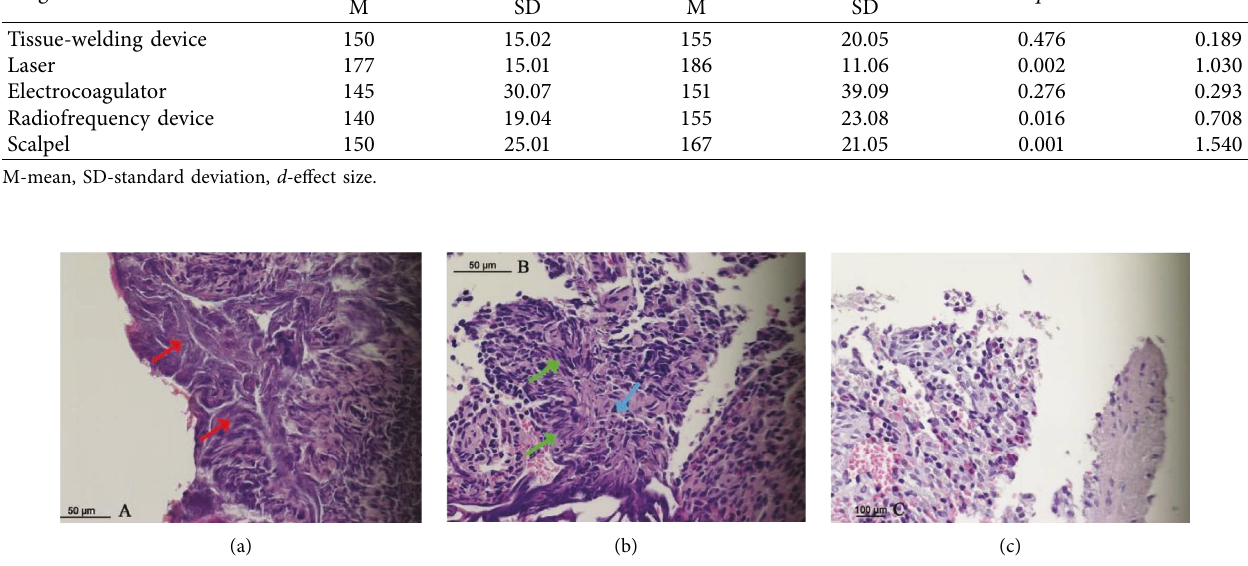
Figure 1: Different cellular changes following the use of various cutting methods. (a).Cut made with a tissue-welding device, obscured and disorganized cells (red arrow). (b).Cut made with a laser, starched nucleus (green arrow) and karyolysis (blue arrow). (c).Cut made with a scalpel with no cellular changes.